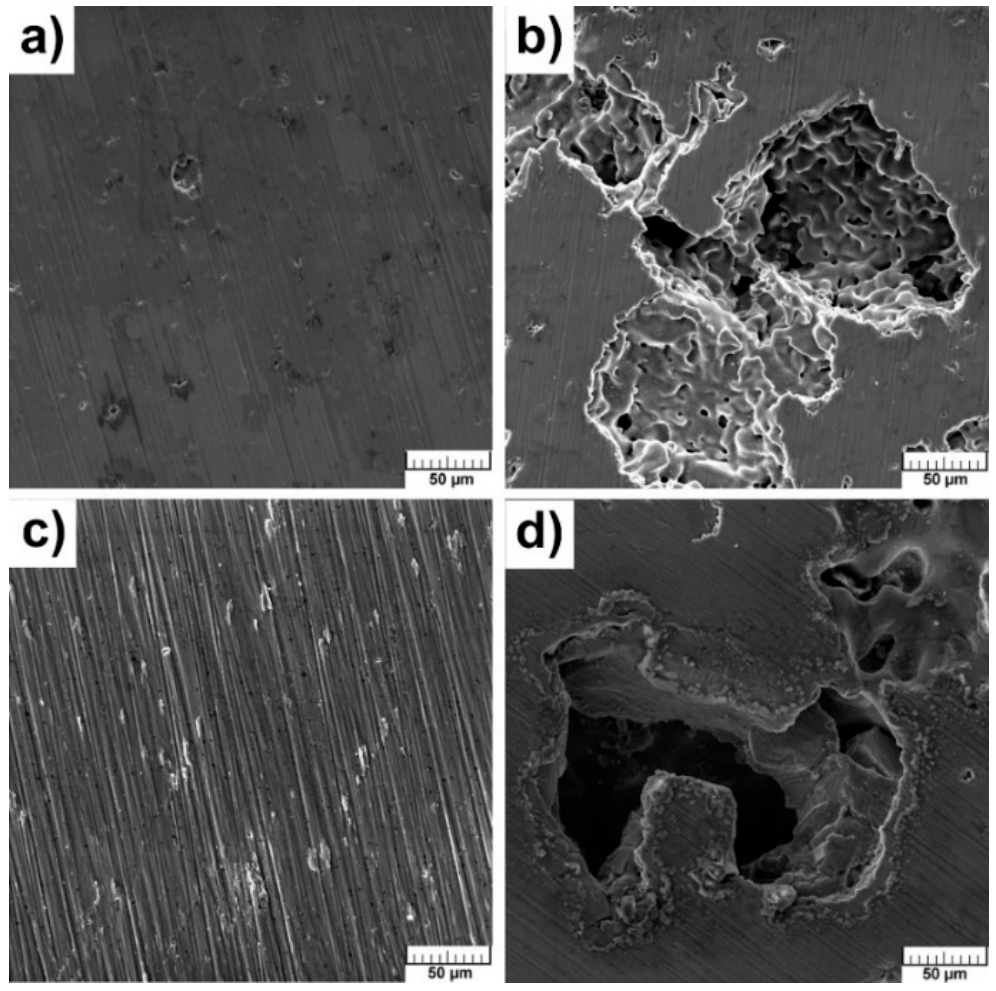
Figure 12. Microstructure of alloys after exposition in SBF: ( a ) TiSi2; ( b ) TiSi2 + 20 wt.% PA; ( c ) Ti; ( d ) Ti + 40 wt.% PA.